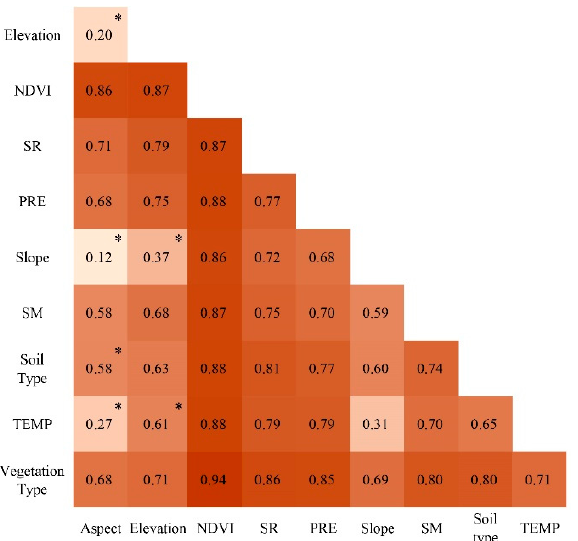
Figure 8. Explanatory power of the interaction of various factors influencing NPP’s spatial pattern in the MP (The * mark on the graph represents non-linear enhancement; unmarked indicates bivariate enhancements.).